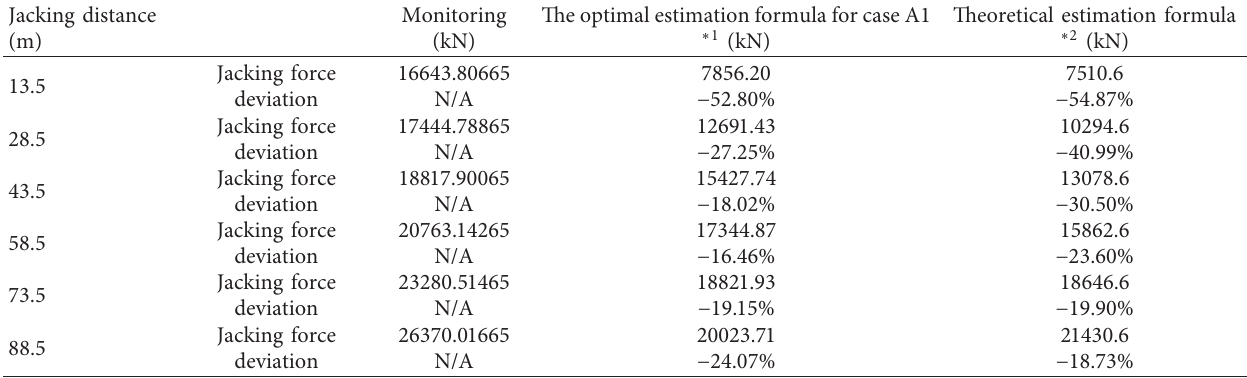
Table 12: The deviation of the jacking force estimations for case A2. Theoretical estimation formula Jacking distance The optimal estimation formula for case A1 ∗ 1 (kN) ∗ 2 (kN)